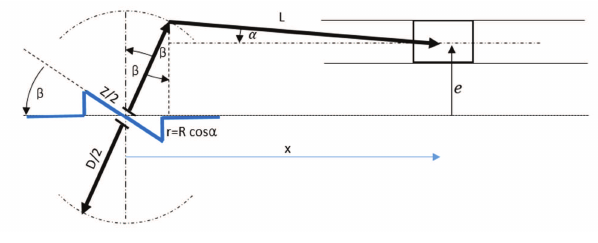
Fig. 3. BE engine scheme